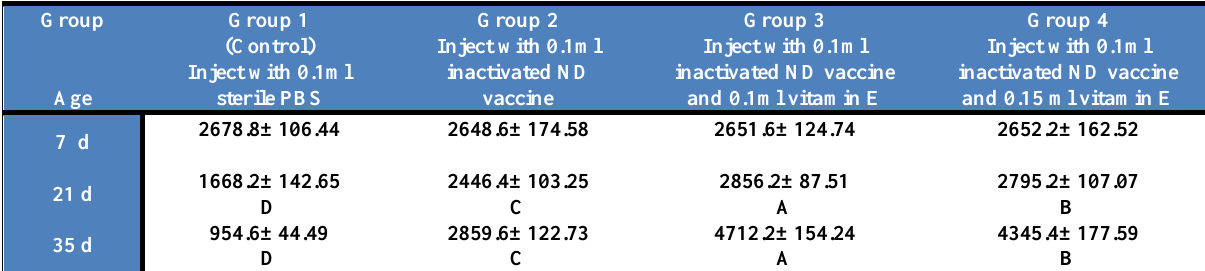
Table, 4: Effect of vitamin E in antibody titres against Newcastle Disease Virus measured by ELISA for different groups. (Mean ± Standard